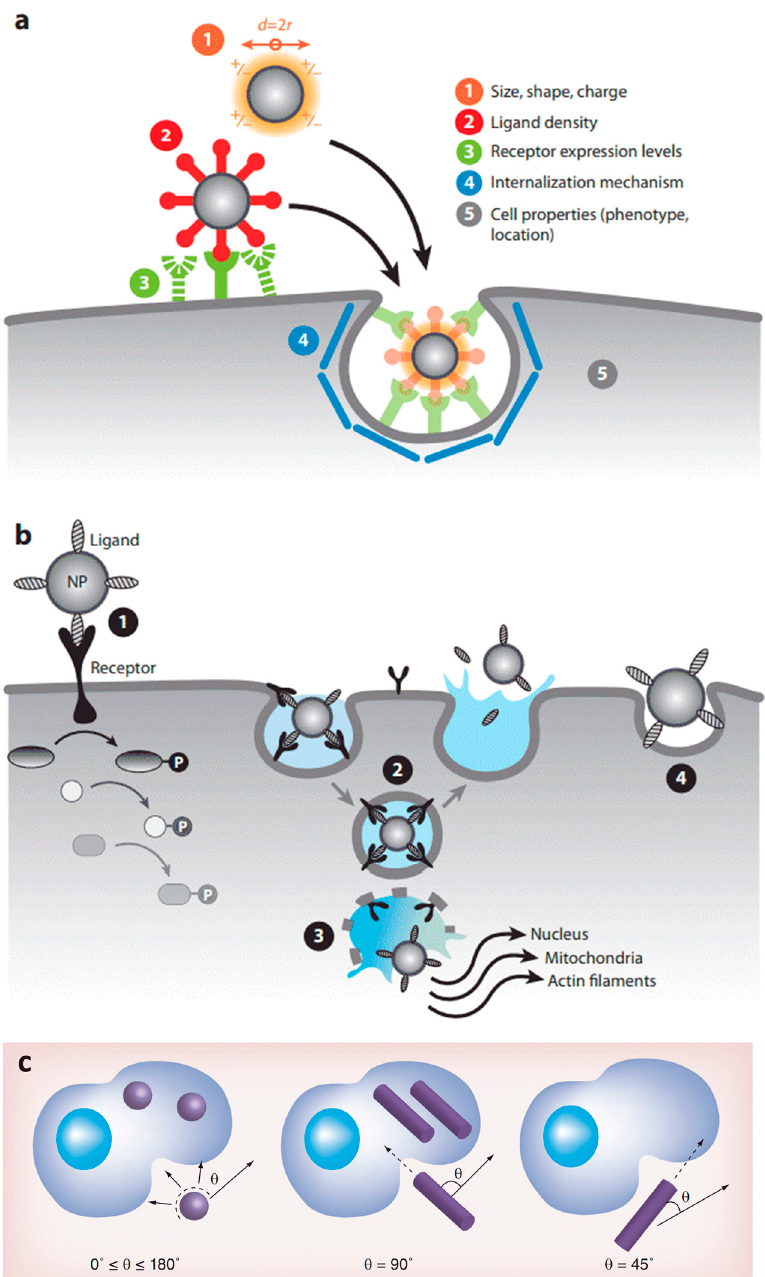
Figure 8. Internalization mechanisms for NPs into cells. ( a ) Factors affecting the internalization, related to the NP and cell properties. ( b ) Uptake mechanism of ligand-coated NPs, where (1) the NPs first bind to receptors on the membrane, inducing an intracellular signaling cascade while staying outside the cell. (2) The NPs may subsequently enter and exit the cell without ever leaving the vesicle; or (3) they can escape the vesicle and interact with different organelles. (4) They may also enter the cell after nonspecifically interacting with its membrane, i.e., not mediated by receptors. ( c ) Influence of the NP shape and contact angle θ on the internalization rate. The latter is independent of θ for spherical NPs due to their symmetry, whereas rod-shaped NPs internalize most rapidly with their major axis perpendicular to the cell membrane. ( a , b ) Used with permission of Annual Reviews, Inc., from [270]; permission conveyed through Copyright Clearance Center, Inc. ( c ) Used with permission of Future Medicine Ltd., from Reprinted from [272]; permission conveyed through Copyright Clearance Center, Inc.